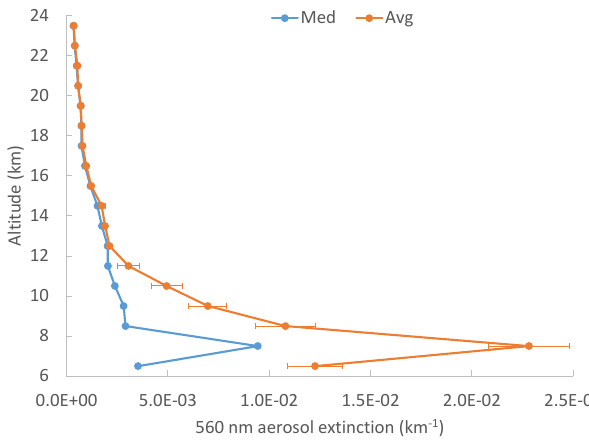
Figure 10. Median and average aerosol extinction observed by MAESTRO at 560nm in May 2010 at northern high latitudes ( N =